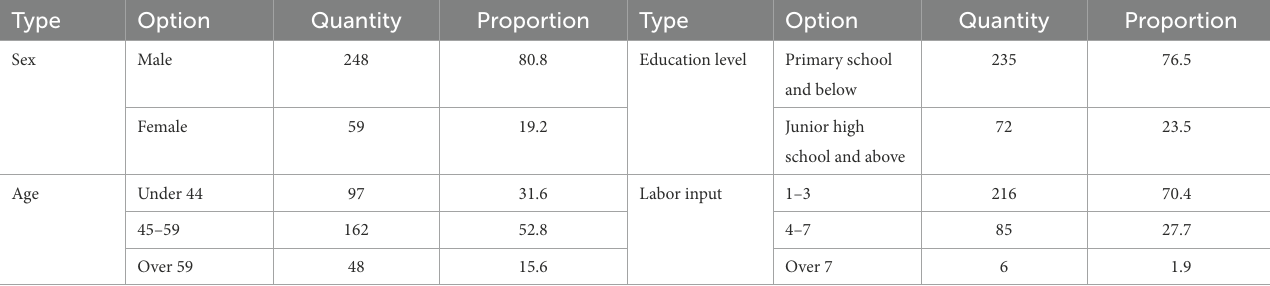
TABLE 1 Main characteristics of the